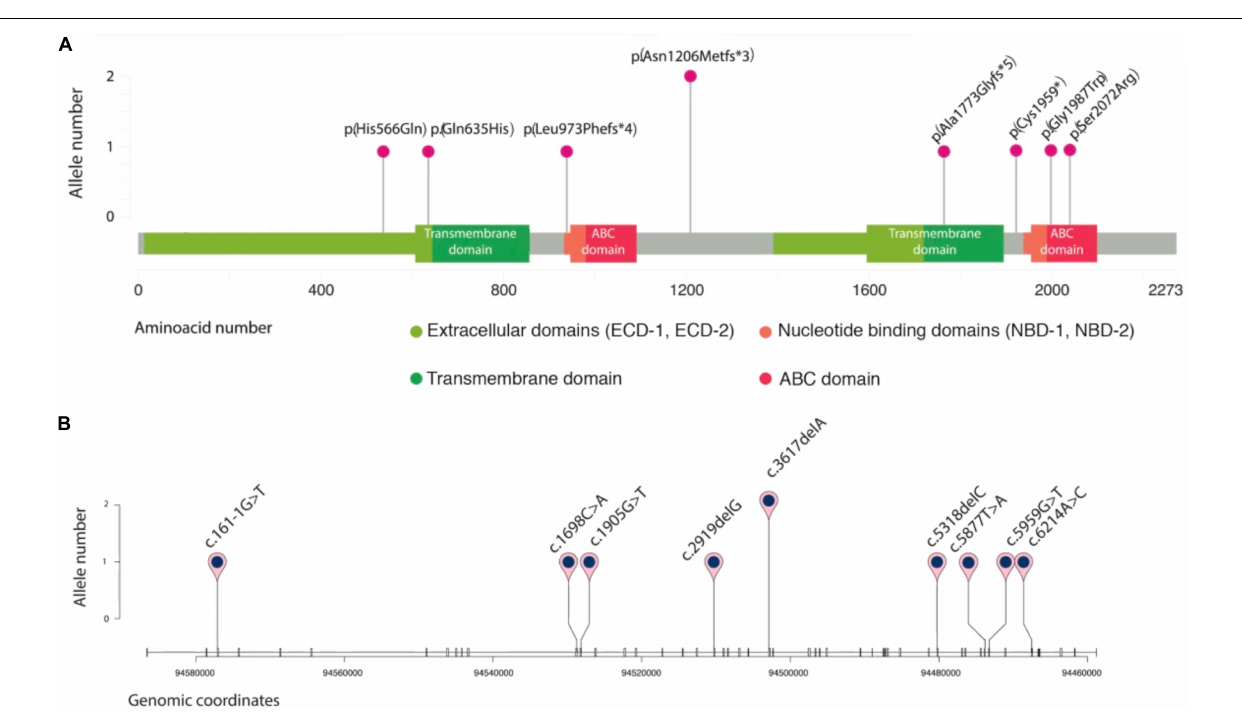
function [Polyphen-2 (score: 0.890), Mutation Taster ( p -value: 0.989), and SIFT (score: 0.03)]. Patient STG 52 also